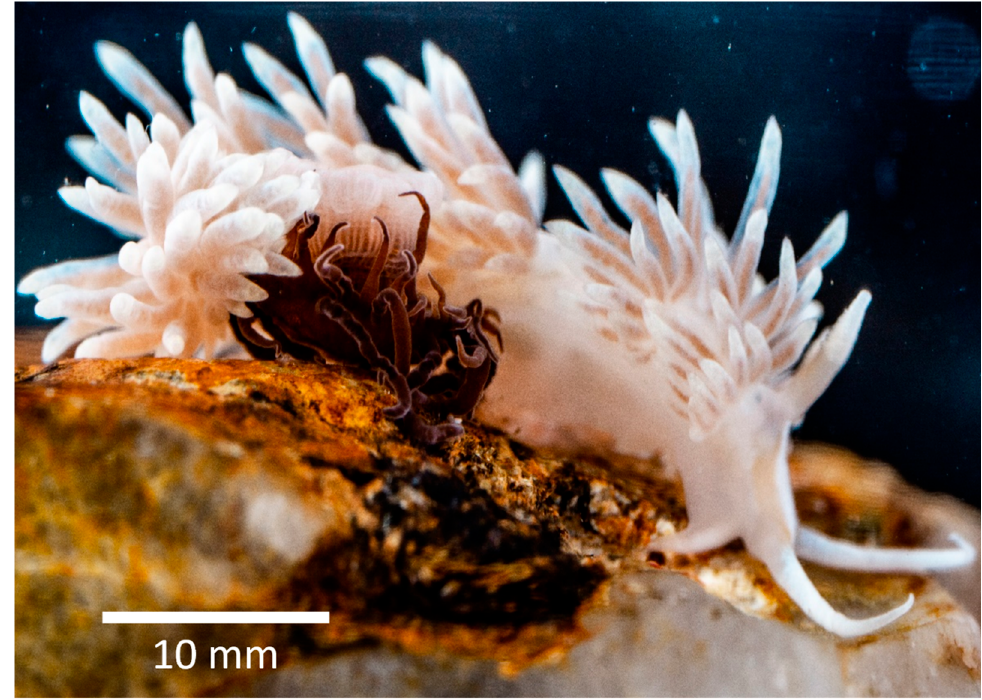
Figure 1. Close-up of Berghia stephanieae alongside its prey Exaiptasia diaphana .